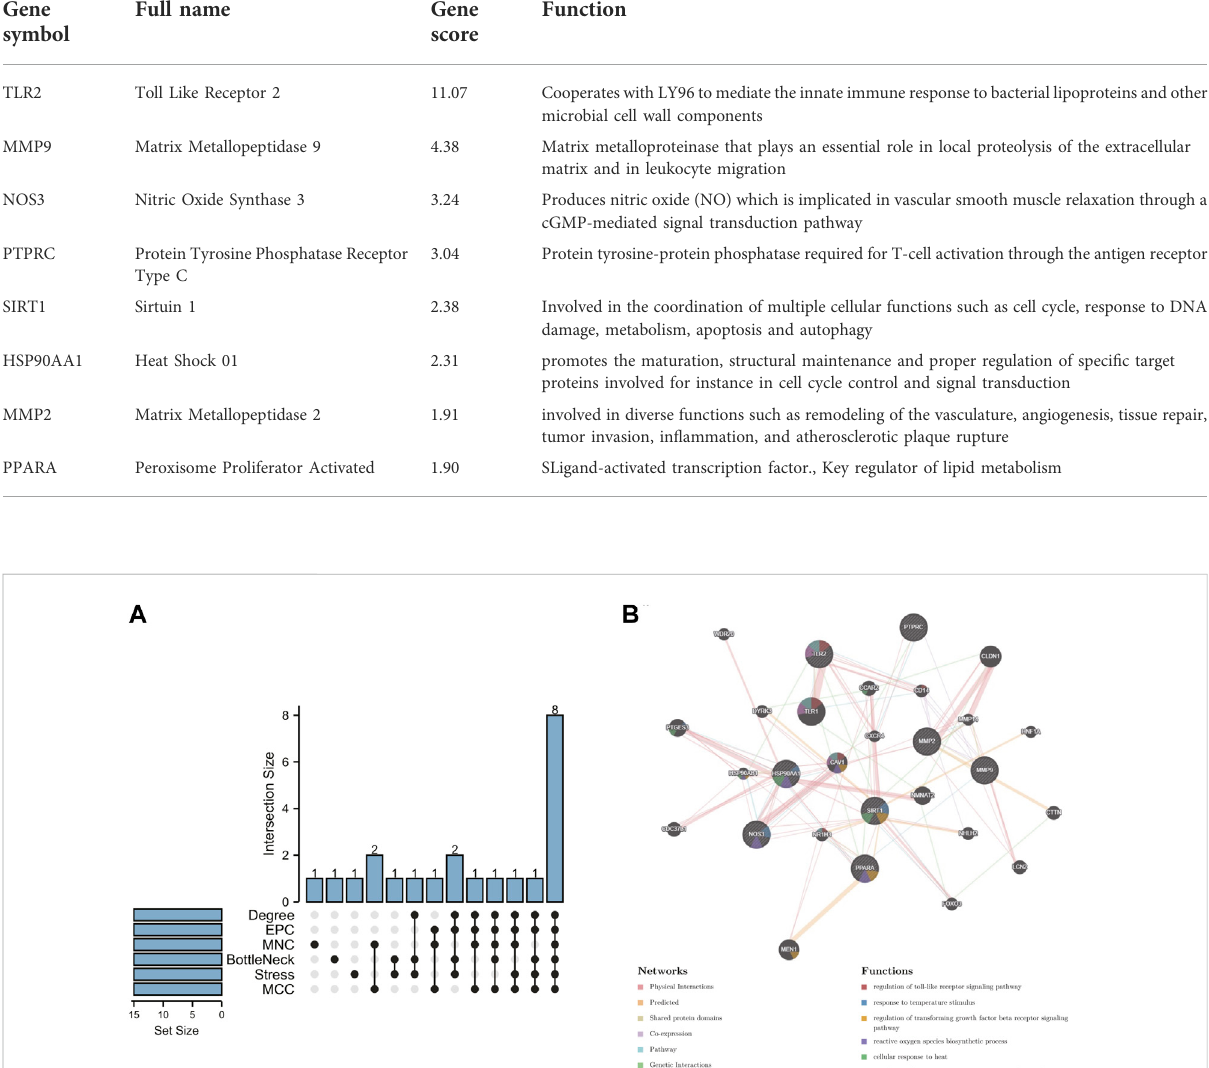
TABLE 2 The details of the hub genes.